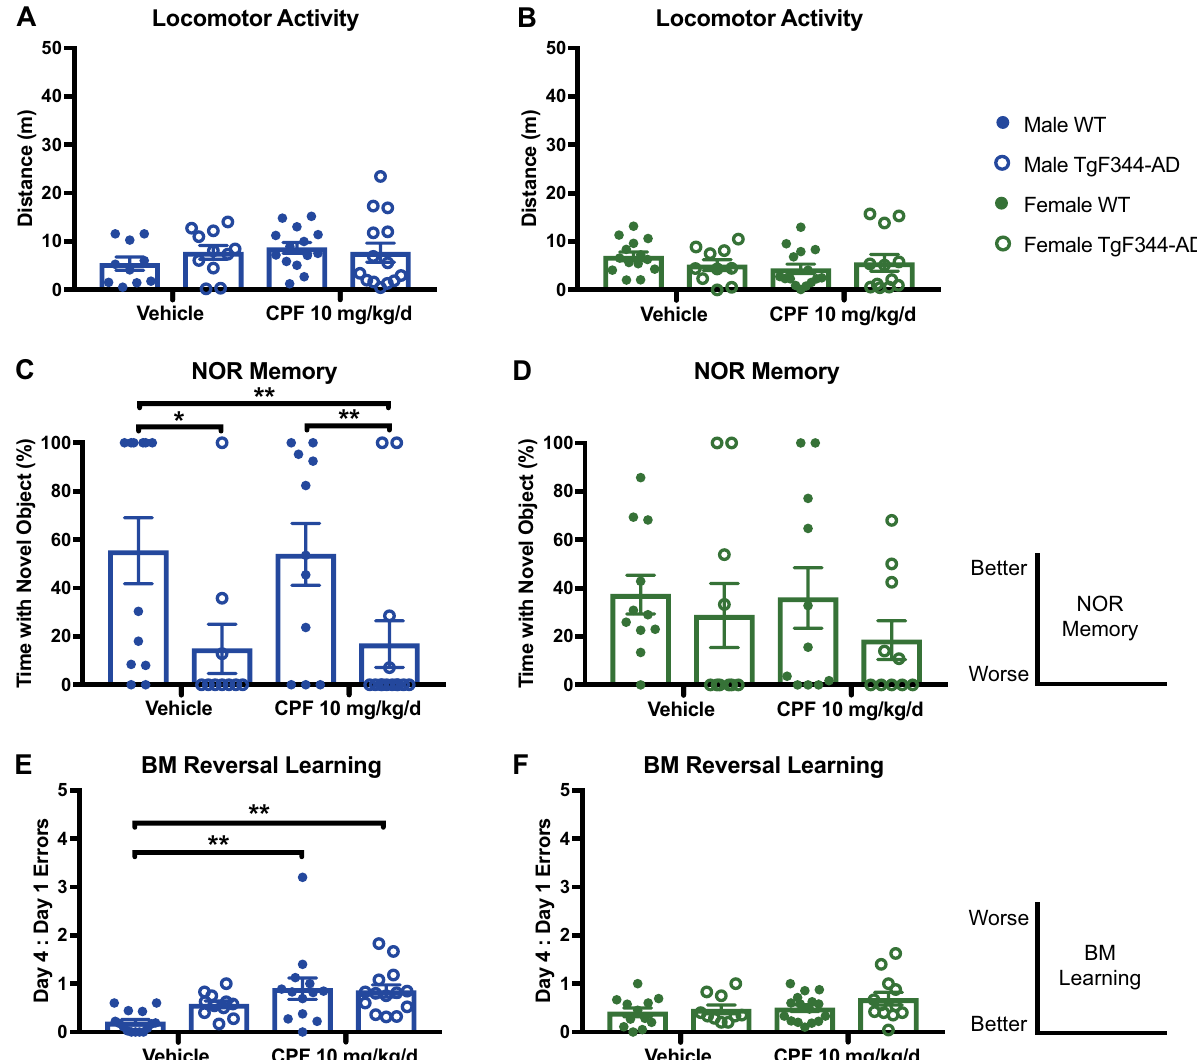
Fig. 2 CPF-exposed 15-month-old TgF344-AD rats display sex-dependent, chronic behavioral de fi cits. a , b Locomotor activity is not signi fi cantly affected by CPF treatment or genotype in males and females at 15 months of age. Open- fi eld treatment effect: male F 1,46 = 0.0603, P = 0.8066; female F 1,47 = 0.7429, P = 0.3931. Open- fi eld genotype effect: male F 1,46 = 0.0723, P = 0.7893; female F 1,47 = 0.0534, P = 0.8176. For each task, the diagrams on the right indicate the relationship of the magnitude of the measured parameter to quality of performance on the task. c – f Learning and memory de fi cits are seen speci fi cally in male TgF344-AD rats. c TgF344-AD males have a lower preference for the novel object in the NOR task, regardless of CPF exposure. NOR treatment effect for males was F 1,43 = 0.0004, P =